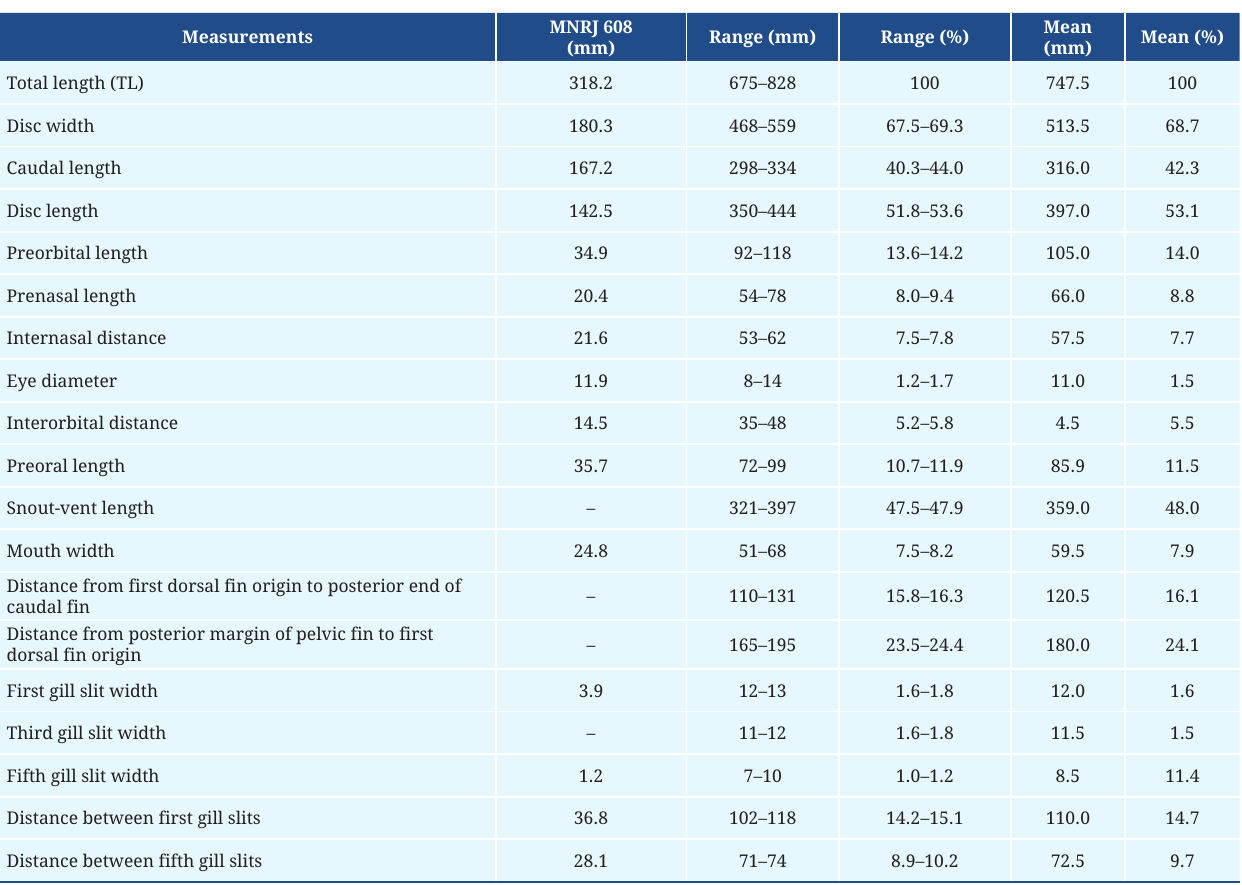
TABLE 1 | Morphometric measurements of six specimens of Atlantoraja castelnaui (including the lectotype, MNRJ 608) in millimeters (mm) and proportions of total length (%).